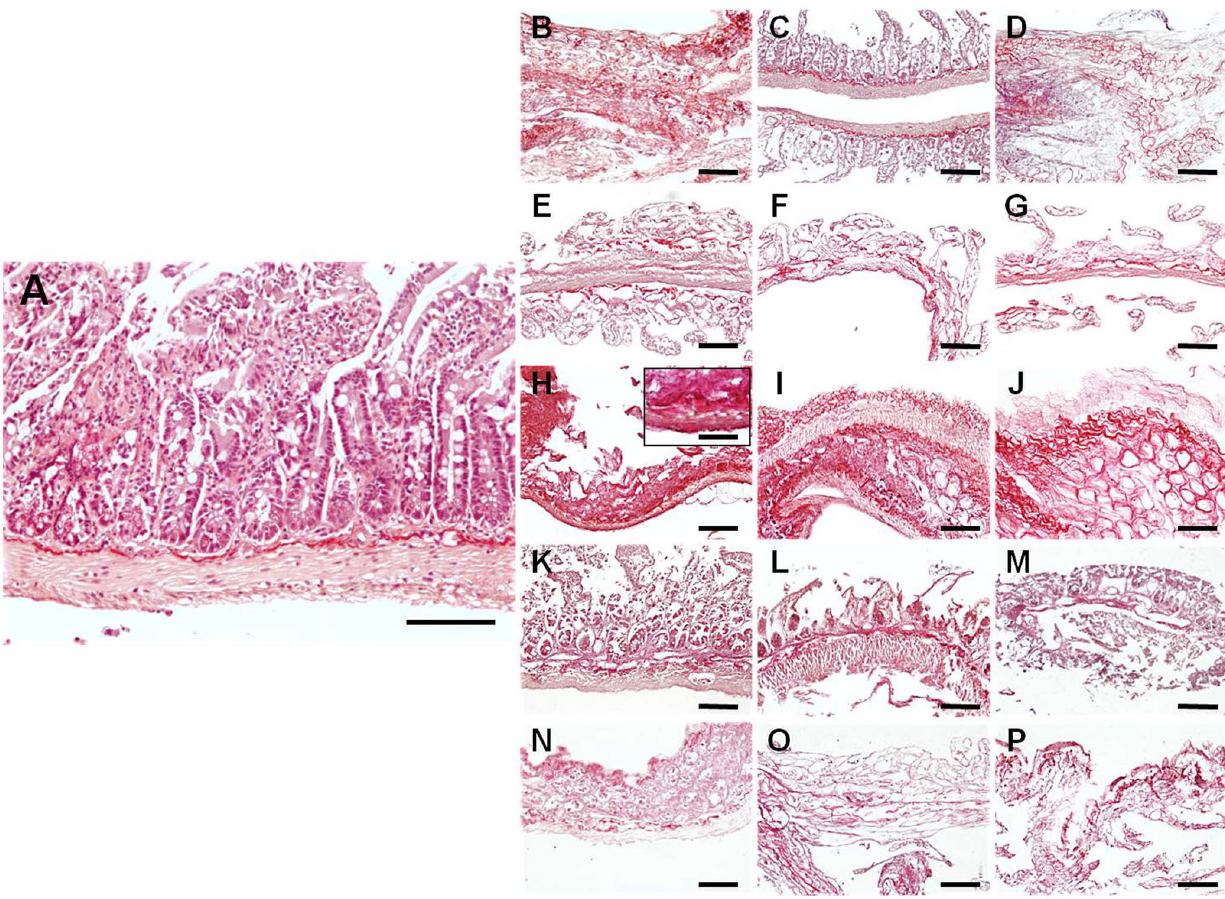
Figure 3. Picrosirius collagen fibers staining of control SI samples (A), and tissues decellularized with 1.5 M NaCl (B), 3 M NaCl (C), 5 M NaCl (D), 0.1% SDS (E), 0.3% SDS (F), 0.6% SDS (G), 0.1% triton X-100 (H), 0.3% triton X-100 (I), 0.6% triton X-100 (J), 10 min SC (K), 20 min SC (L), 30 min SC (M), 10 min UV (N), 20 min UV (O) and 30 min UV (P). All scale bars represent 200 m m, with exception of the insert representing a higher magnification image (scale bar=800 m